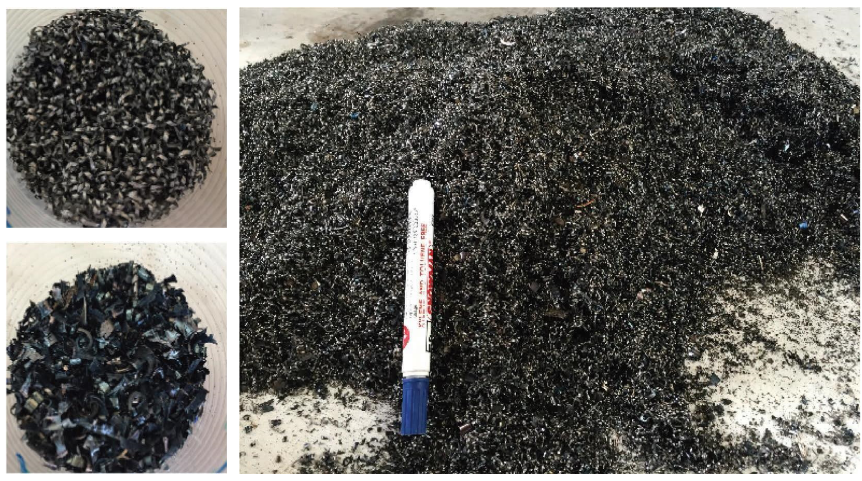
Figure 3: Steel shaving used in this